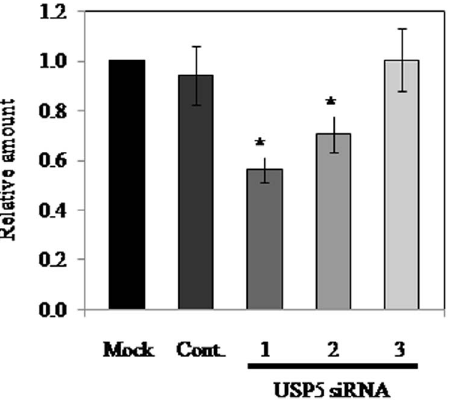
Figure 3. TNF- a production in USP5 siRNA-knockdown cells. TNF- a production was calculated as the total amount of TNF- a released into the supernatant and TNF- a remaining within the cells based on ELISA. The significance of differences from control values was calculated using the Student’s t-test (*p , 0.05).